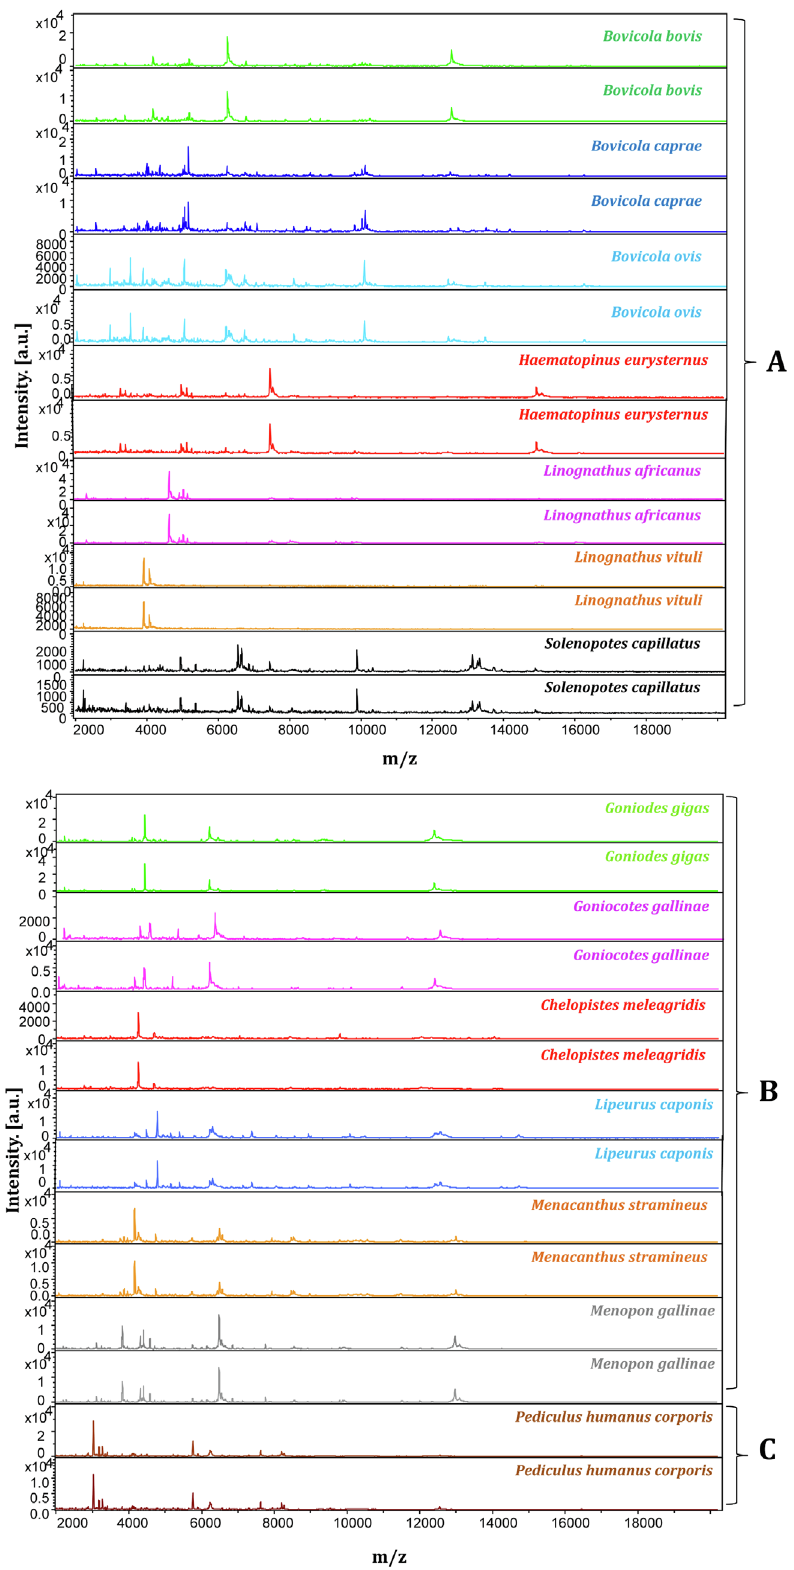
Figure 5. Good quality spectra of different species of mammalian and poultry lice visualized using FlexAnalysis software. (A: Mammal lice / B: Poultry lice / C: Human